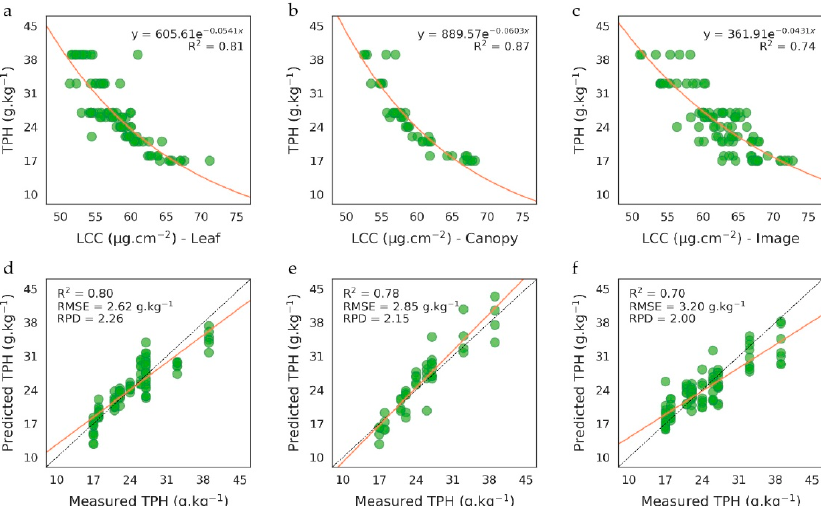
Figure 3. ( a – c ) Relationship between LCC and soil total petroleum hydrocarbons (TPH) content observed on the training set on the 10 plots of the brownfield, at ( a ) leaf and ( b ) canopy scales and ( c ) on the airborne image. ( d – f ) Comparison between measured and predicted TPH concentrations on the test set, at ( d ) leaf and ( e ) canopy scales and ( f ) on the airborne